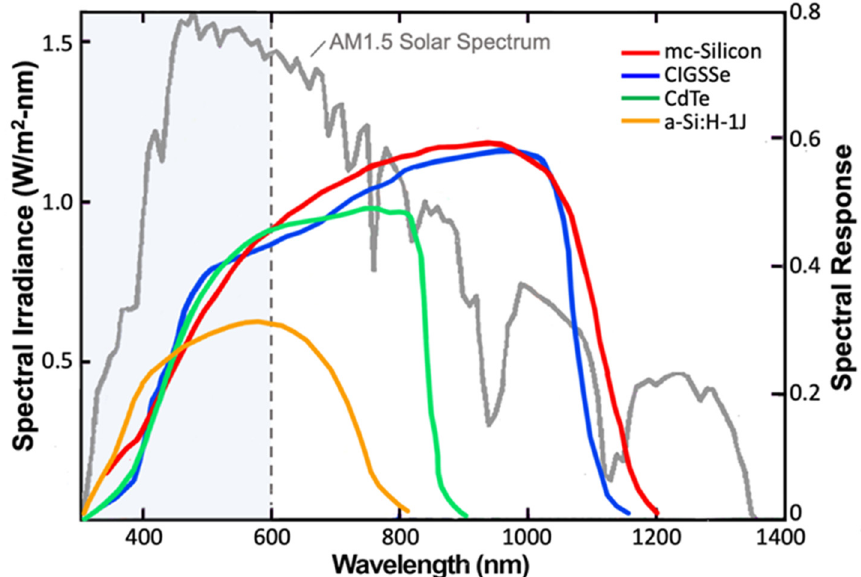
Figure 1. Spectral response comparisons of c-Si, CdTe, CIGS, and a-Si:H modules from this study, indicating responses in various spectral regions compared to AM1.5 solar spectrum (following the method of J. John et al.) [30]. Region from 300 to ~600 nm (shaded) has been identified as critical for dust absorption of the solar irradiation in several geographical regions, including those in this study. This graph indicates that the greater effect on power output is for the lower bandgap absorber technologies due to possible spectral absorption by the soiling layer in the lower wavelength regions.